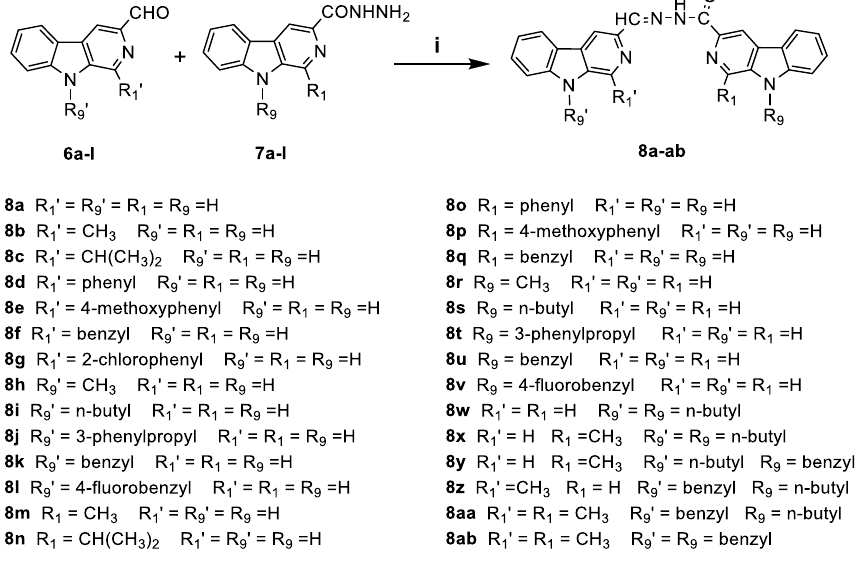
Table 1. Cytotoxic activity of acylhydrazone linked heterobivalent β-carbolines 8a – ab in vitro a (IC 50 , µM b